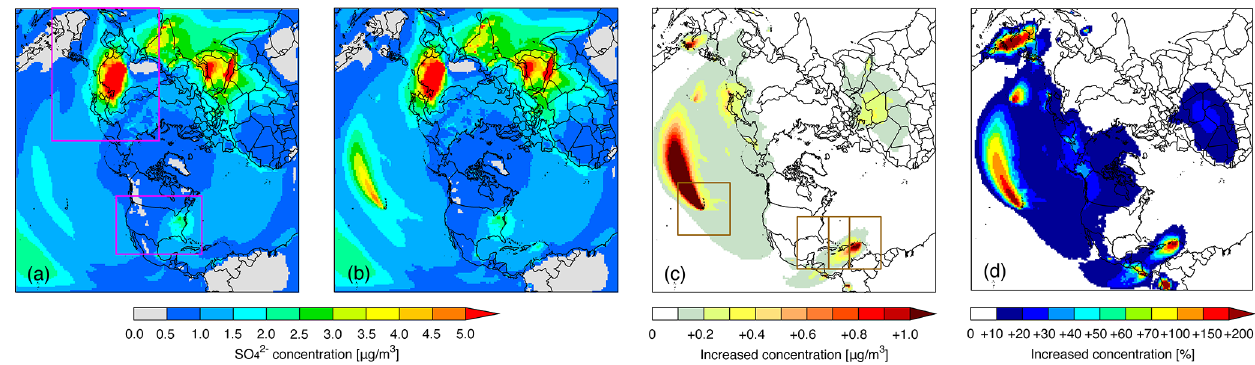
Figure 3. Simulated annual averaged SO 2 − concentration in 2010 by (a) original H-CMAQ and (b) H-CMAQ with incorporation of volcanic 4 SO 2 emissions, (c) increased concentration by the incorporation of volcanic SO 2 emissions, and (d) same as (c) but shown as relative percentages at the surface. The rectangular regions colored in pink in (a) indicate the Asia (top left) and USA (bottom right) subdomains used for detailed analysis. The rectangular regions colored in brown in (c) indicate areas for the analysis on specific site analysis that were largely impacted by degassing SO 2 volcanoes.